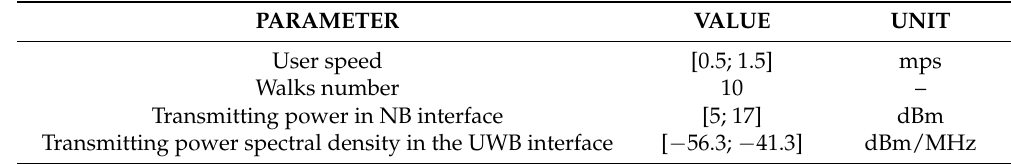
Table 4. The chosen parameters of the WBAN heterogeneous